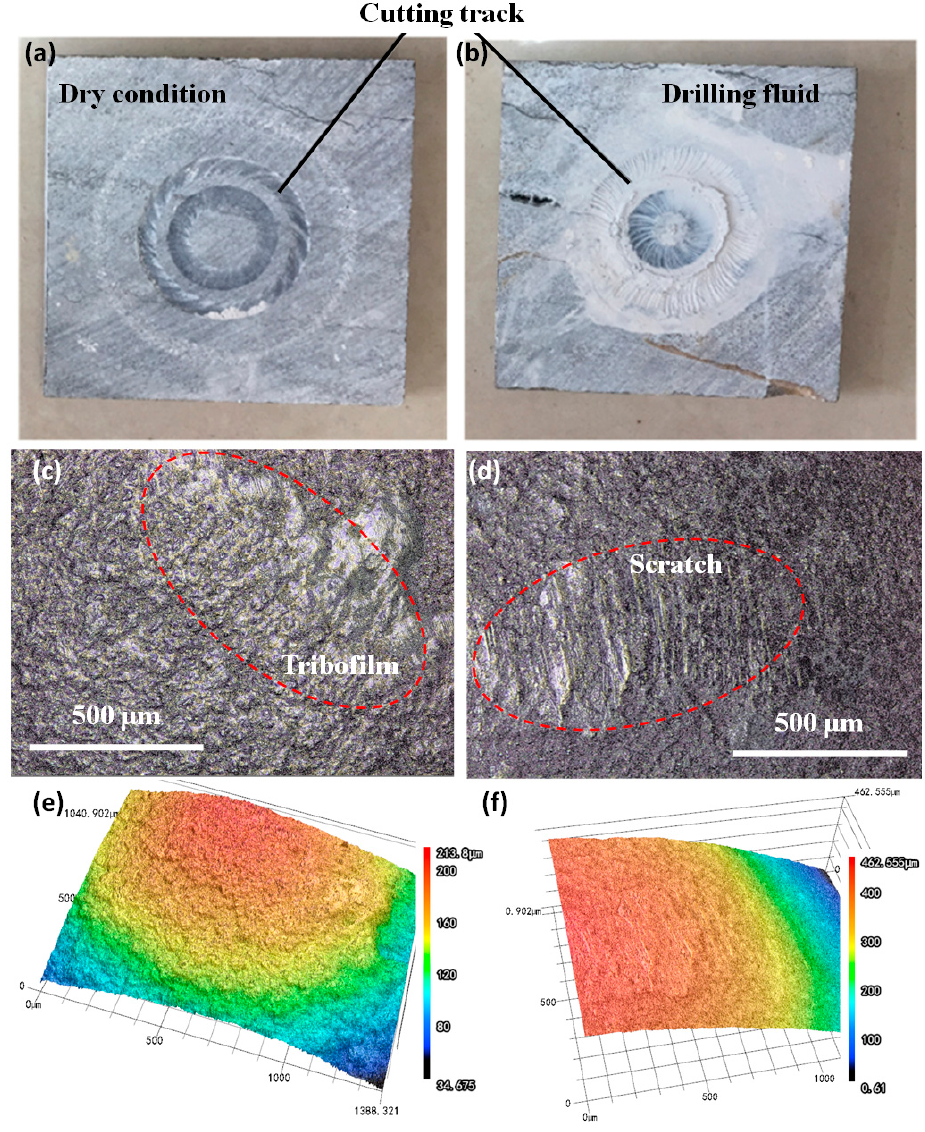
Figure 10. ( a , b ) Photos of wear tracks on the limestone, ( c , d ) two-dimensional (2D) and ( e , f ) three-dimensional (3D) profiles of cutter tip after wear test. Left column: in the dry condition, right column: in the drilling fluid environment.